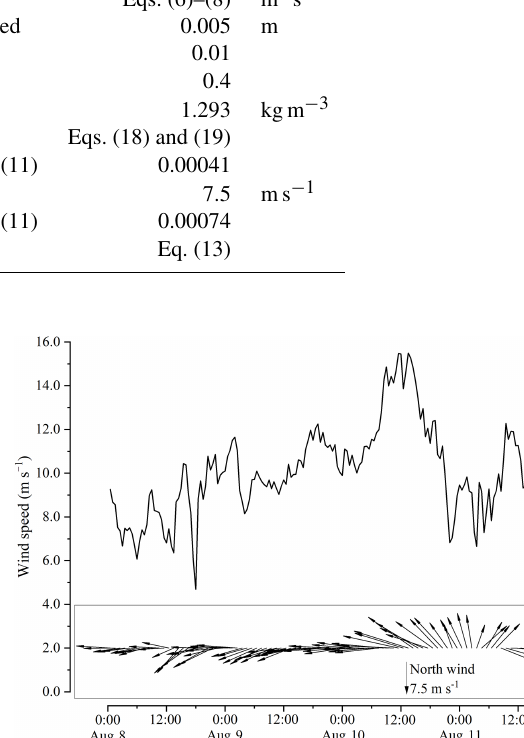
Table 1. Parameter values and variable equations used for lake current simulation in the LCM. Parameter Description Value Unit ϕ Latitude 31.245 g Gravitational acceleration 9.8 A H Horizontal eddy viscosity Vertical eddy viscosity Roughness height of lake bed Roughness of lake surface